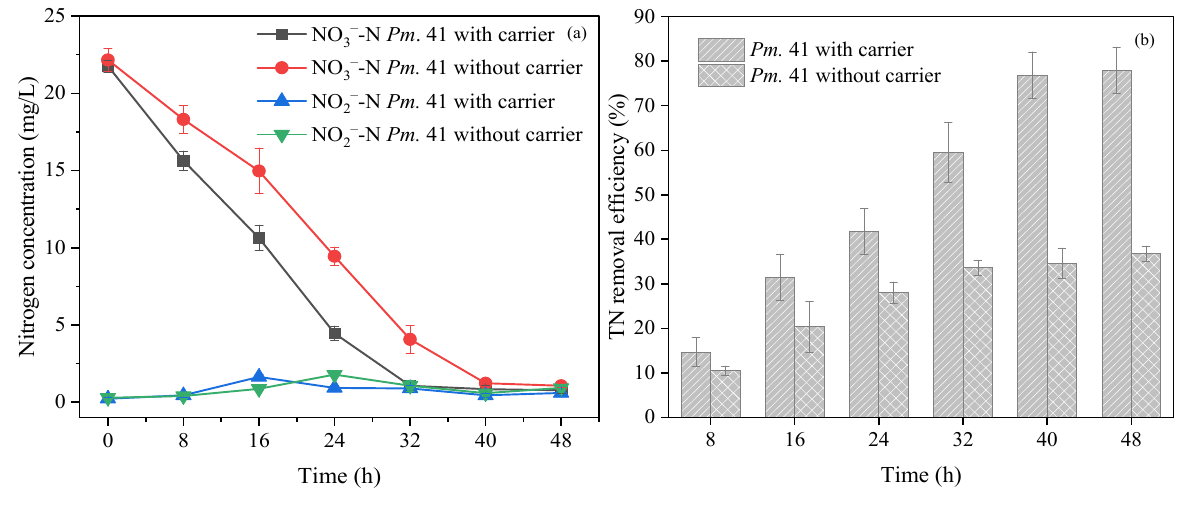
Figure 9. Nitrogen removal characteristics of strain 41. ( a ) Changes of NO 3 − -N and NO 2 − -N concen- trations in experimental group and control group; ( b ) removal efficiency of TN in the experimental group and control group.